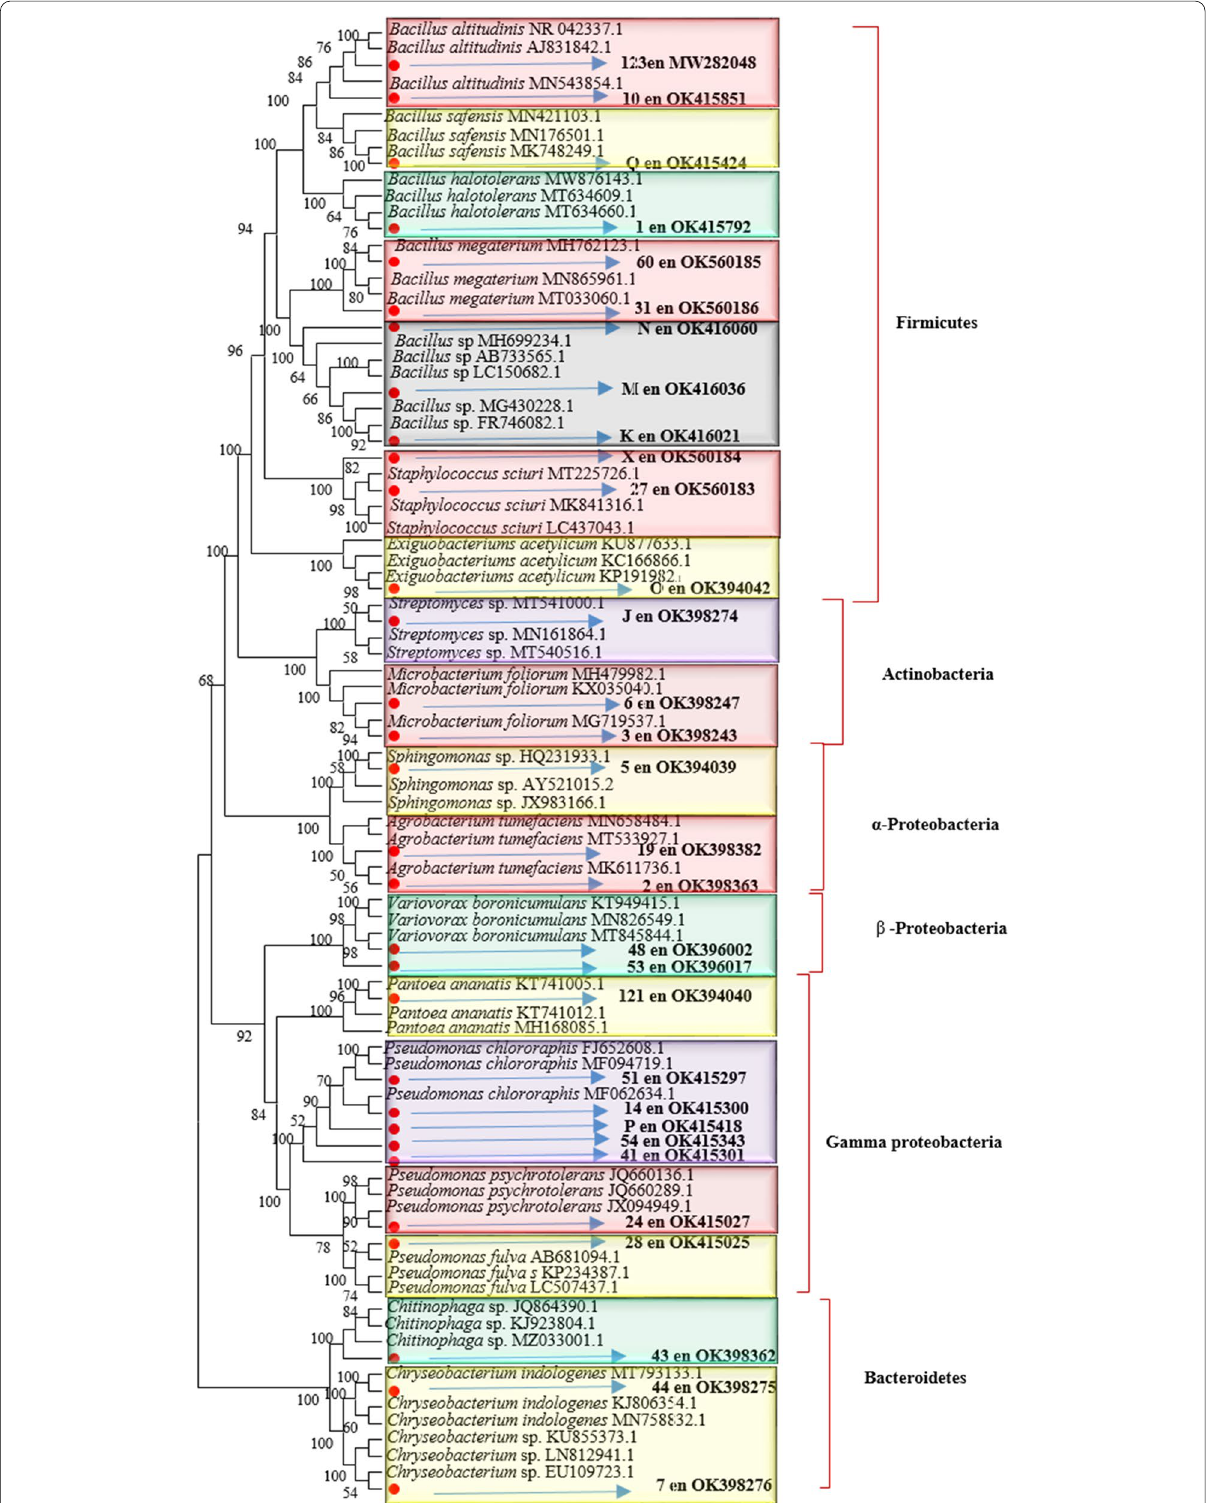
Fig. 2 Phylogenetic tree of isolated endophytic bacteria from kiwifruit based on the 16 s rRNA gene sequences constructed in the MEGA X program based on the maximum likelihood method and bootstrap values (values > 50%) based on 1000 replications. Bacillus megaterium and Staphylococcus sciuri have changed to Priestia megaterium and Mammaliicoccus